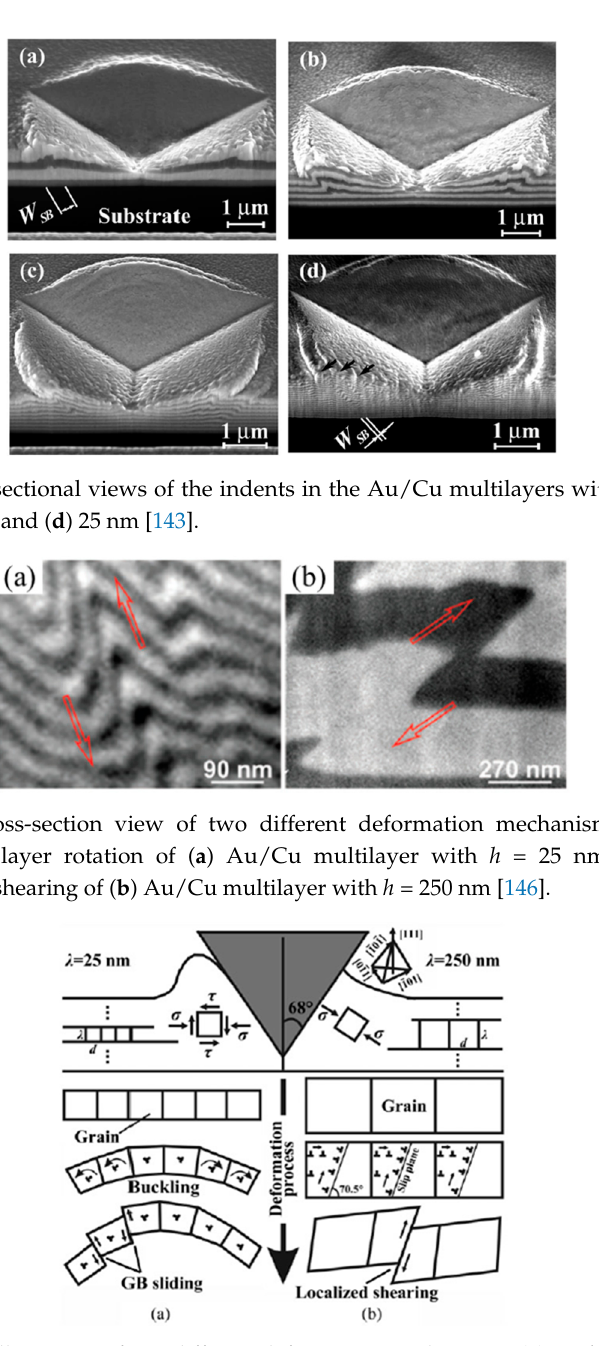
Figure 26. Schematic illustration of two different deformation mechanisms: ( a ) Au/Cu multilayer with h = 25 nm, which is corresponding to the elastic buckling-assisted GB sliding; and ( b ) Au/Cu multilayer with h = 250 nm, which is corresponding to the dislocation plasticity-dominated shearing [88].